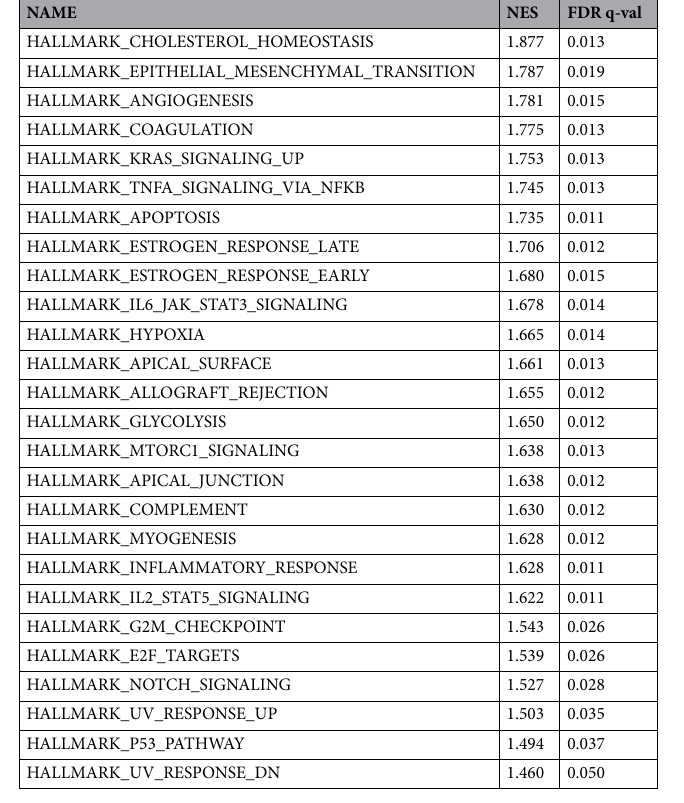
Table 1. Gene sets enriched in wild type mice. Data with false discovery rate (FDR) q < 0.05 are shown. NES; normalized enrich